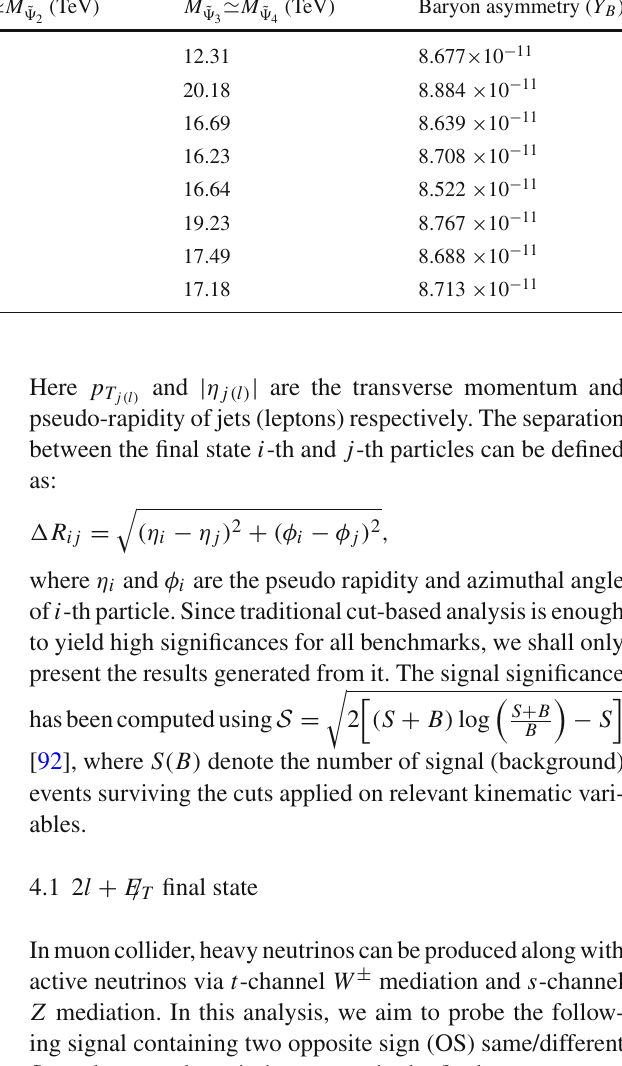
Table 2 Benchmark points characterizing the masses of the heavy neutrinos satisfying the observed baryon asymmetry within 1 σ error bar